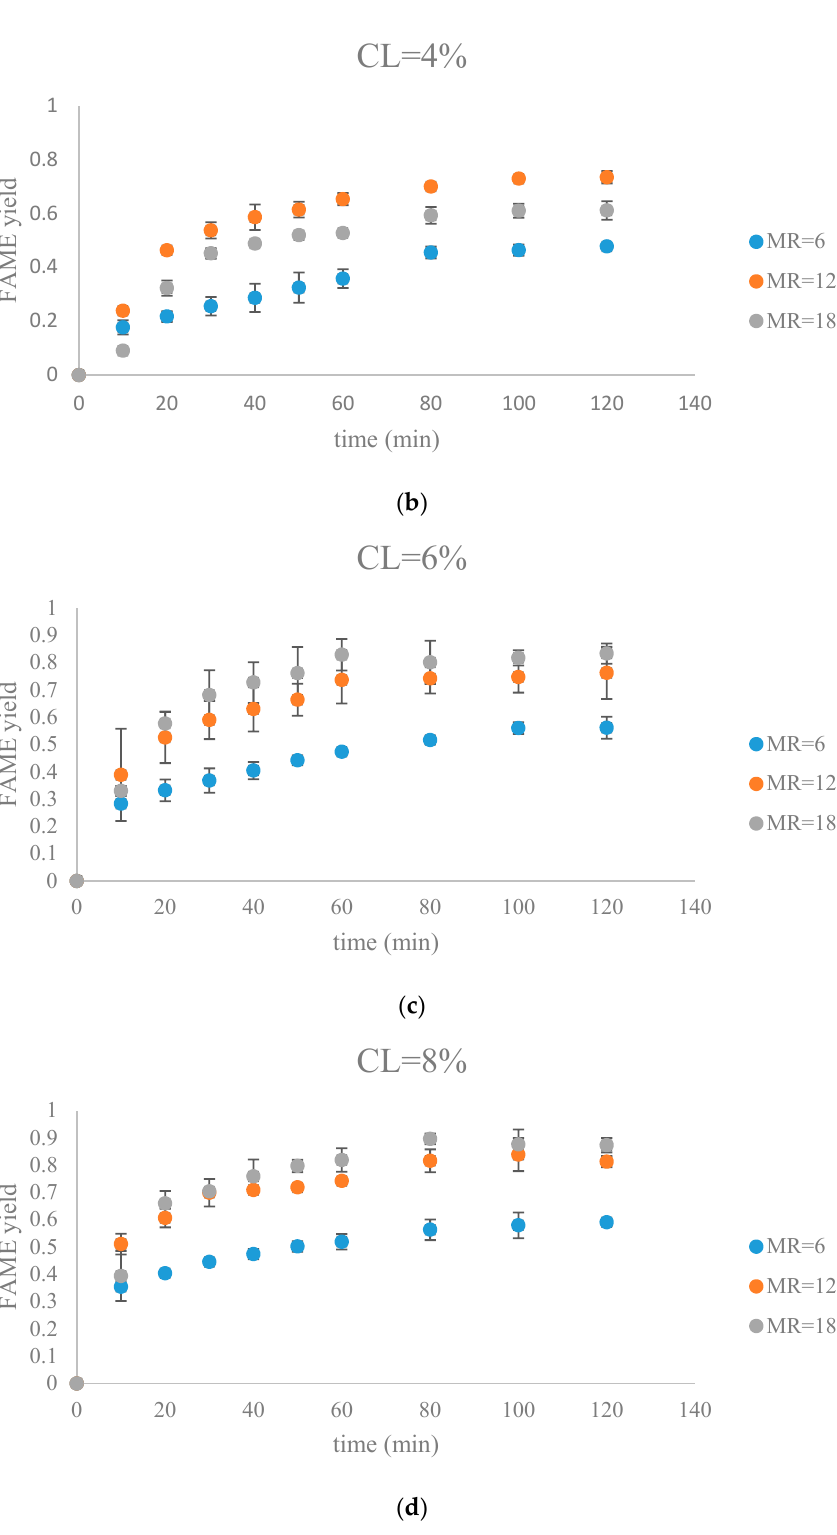
Figure 8. The FAME yield with the progress of the soybean oil transesterification catalyzed by Na-COS grouped by CL ( a ) CL = 2%; ( b ) CL = 4%; ( c ) CL = 6%; ( d ) CL = 8%).